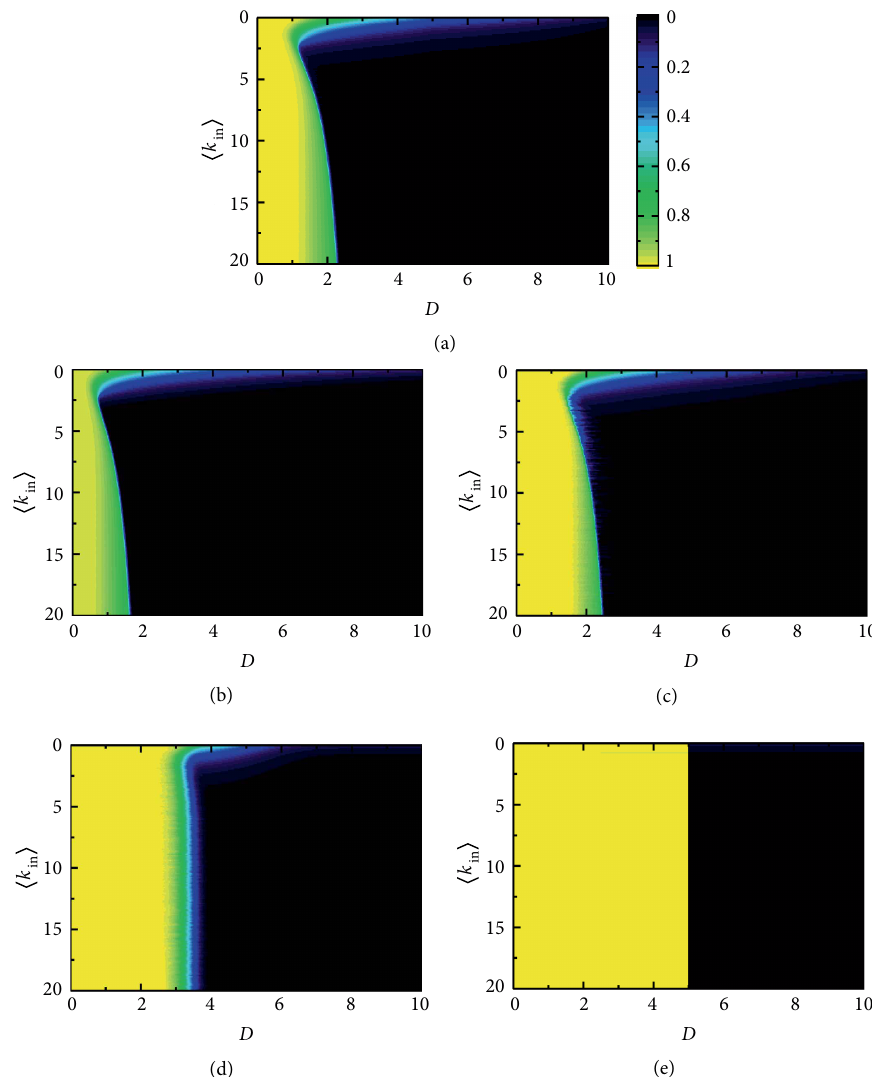
Figure 5: Phase diagram of the market robustness 𝑅 in the plane 𝐷 - ⟨𝑘 in ⟩ for 𝑇 = 0.5 and different weight distributions: uniform (a), exponential (b), truncated normal with dispersion 𝜎 = 3 (c), 𝜎 = 1 (d), and 𝜎 = 0 (e). Yellow corresponds to 𝑅 = 1 and black to 𝑅 = 0 . For all weight distributions, the mean weight is 𝐶 = 5 . The internal degree distribution corresponds to an ER network with ⟨𝑘 in ⟩ = 4 . The initial shock is in the VC layer. The results were averaged over 100